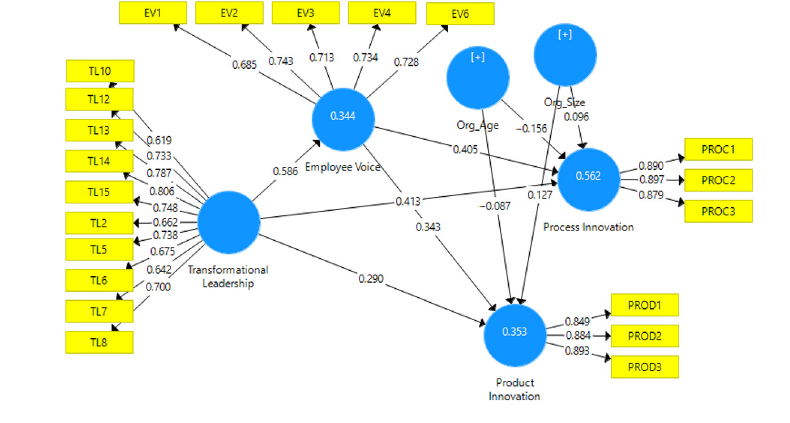
Figure 1. The measurement model (outer model)